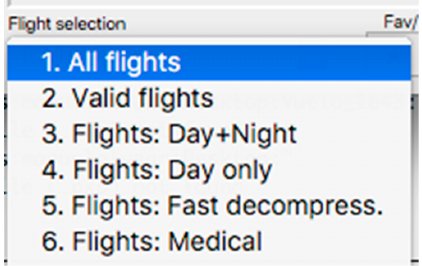
Figure 14. Visualization of the displayed panel with the types of flights performed in the hypobaric chamber.